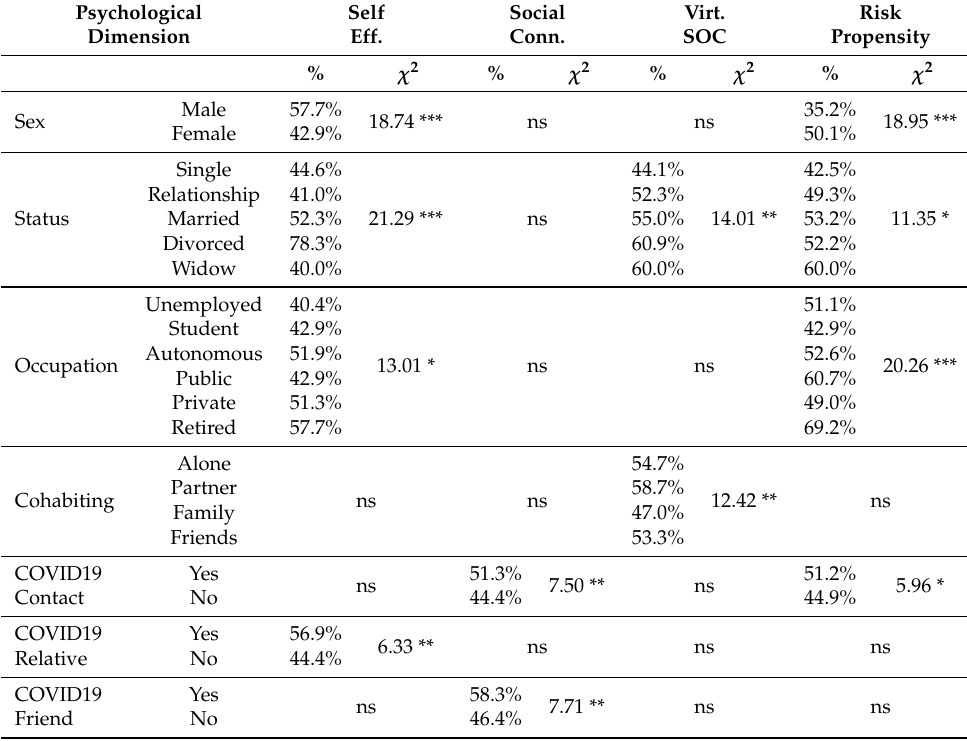
Table 3. Relations between psychological variables not related to well being, and discrete socio-demographic and COVID-19 related variables. For the sake of simplicity, we only reported in table the percentages of observations that were characterized by greater values than the median.